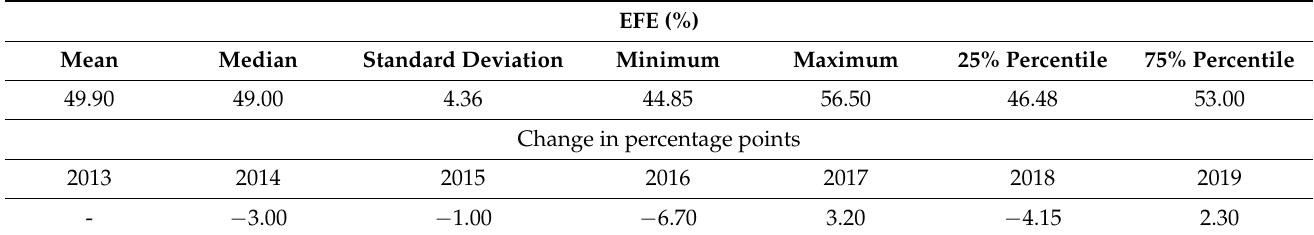
Table 7. Efficiency ratio (EFE) of the Lithuanian banking sector in the period of 2013–2019.